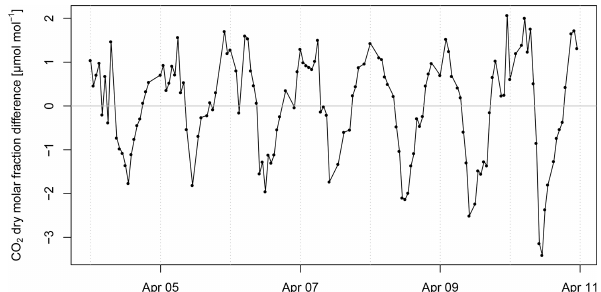
Figure 11. Dry molar fraction of CO 2 in the updraft and downdraft reservoirs of the true eddy accumulation device, in red and blue, re- spectively. The difference in molar fraction is a result of the vertical CO 2 flux.